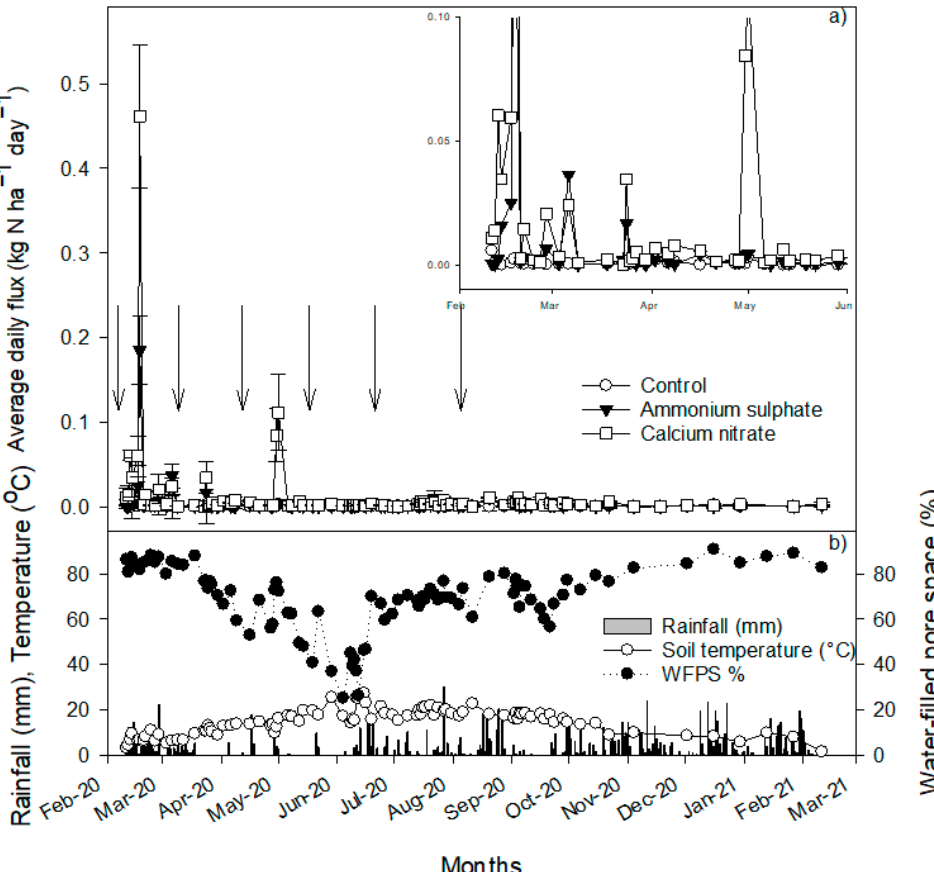
Figure 1. ( a ) Average N 2 O flux from the fertilizer treatments during the experimental period. Arrows indicate fertilizer application timing. The insert is an enlargement of the plot for improved visibility. Error bars indicate 1 SE (n = 5). ( b ) Average soil (5 cm depth) temperature, rainfall and water-filled pore space (WFPS) over the measurement period.